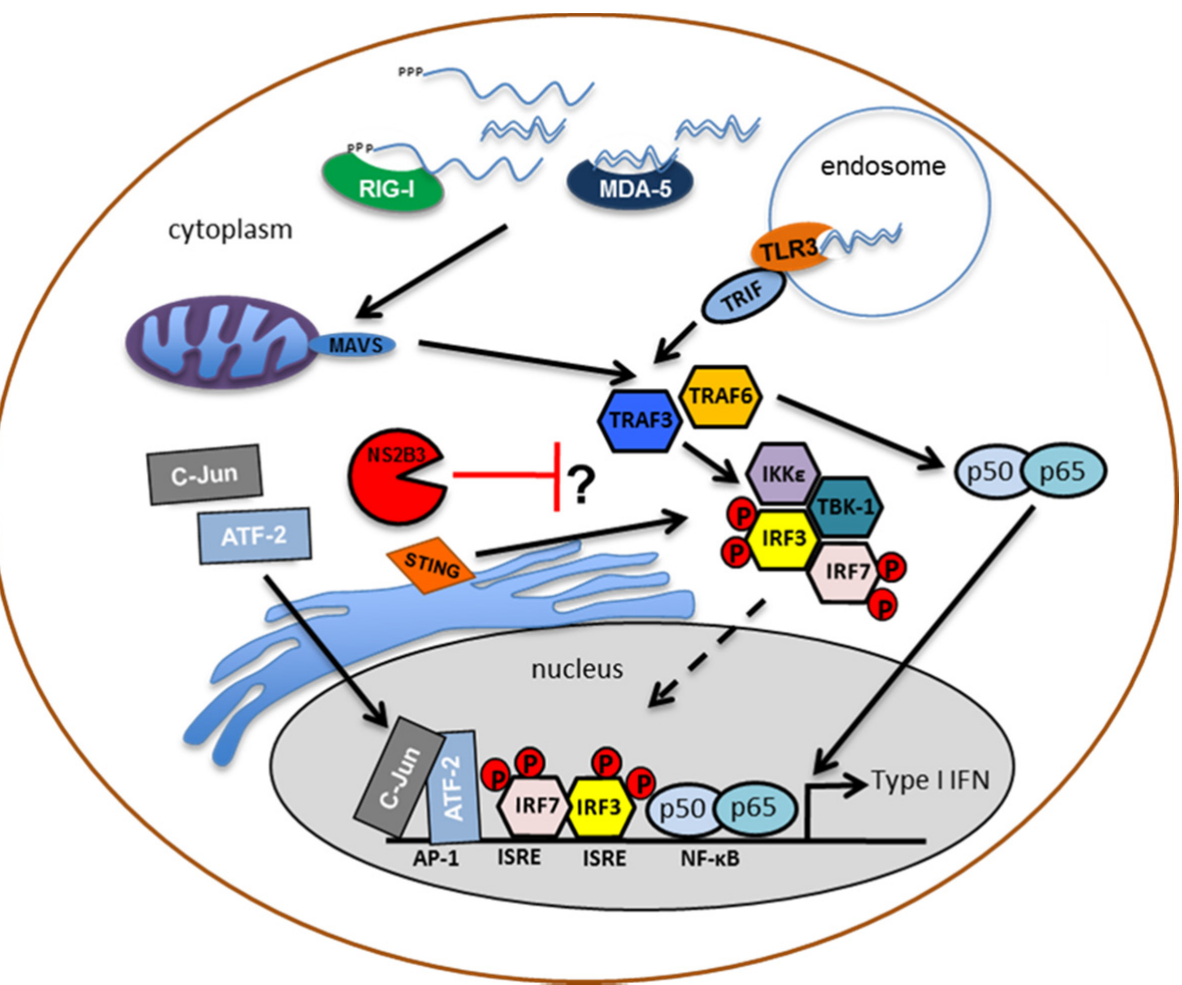
Figure 2. Inhibition of type I IFN production by DENV: The recognition of DENV replication intermediates by the cytosolic helicases, RIG-I and MDA-5, induces a conformational change that promotes the interaction between the caspase-recruitment domain (CARD) of these pattern-recognition receptors and the CARD-containing adaptor, MAVS. Furthermore, the membrane-bound protein, Toll-like receptor 3 (TLR3), binds dsRNA in endosomes, inducing the activation of the adaptor protein, TRIF. All of these pathways converge in the recruitment and activation of the IKK ε /TBK-1 complex. This activation induces phosphorylation and homo- and hetero-dimerization of transcription factors, IRF3 and IRF7, which translocate to the nucleus to induce the expression of type I interferon together with activated NF- κ B and AP-1. The DENV protease complex inhibits the phosphorylation of IRF3 thereby resulting in a lack of type I IFN production in human dendritic